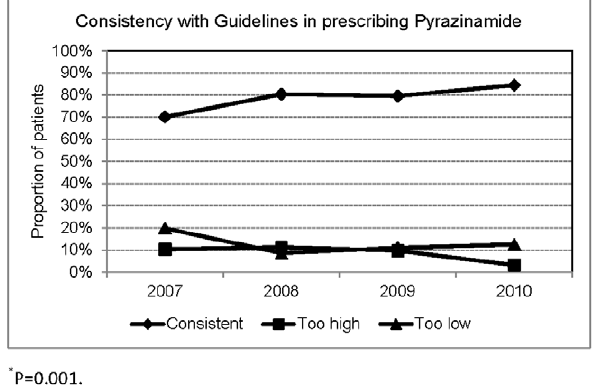
Figure 7. Consistency with Taiwan Guidelines in prescribing Pyrazinamide.